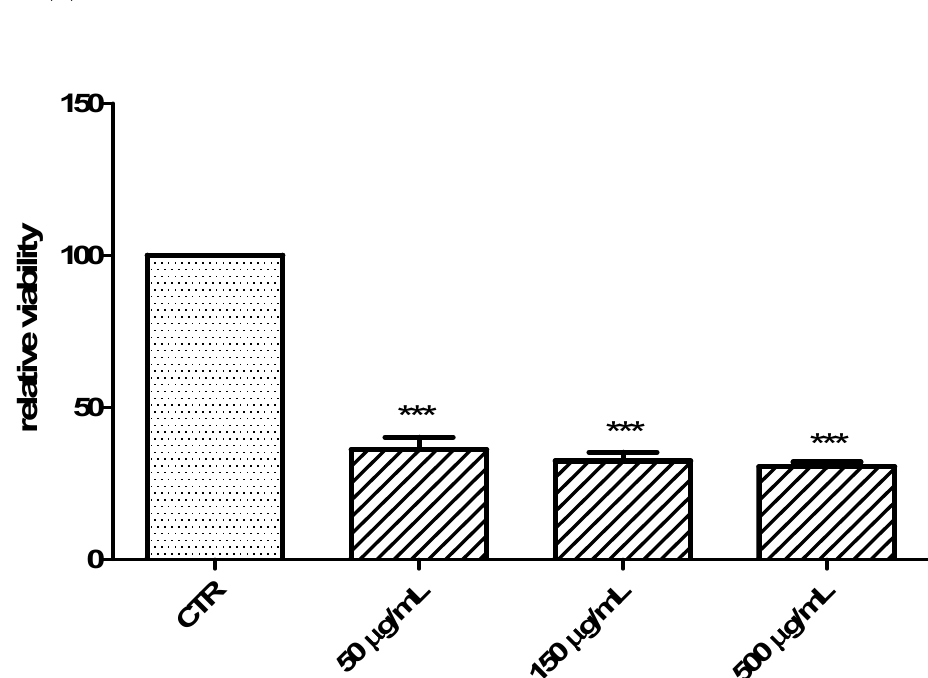
Figure 5. Antiproliferative effect of C. minima hydroalcoholic extract 50–500 µg/mL on human colon cancer HCT116 cell viability [3-(4,5-dimethylthiazol-2-yl)-2,5-diphenyltetrazolium bromide (MTT) test] in basal conditions. ANOVA, p < 0.0001; *** p < 0.001 vs. CTR group.